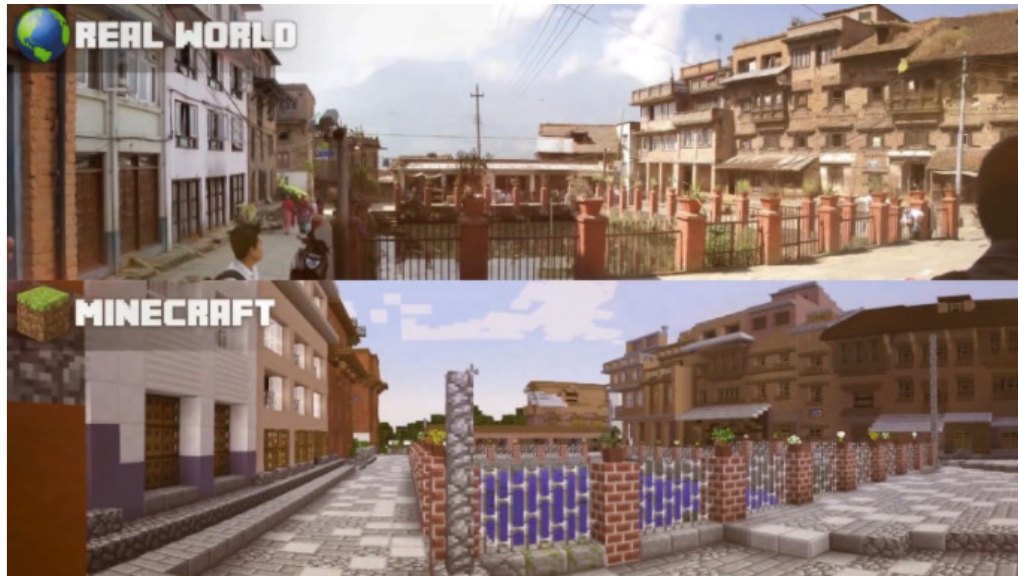
Figure 8. Block by block mirroring community